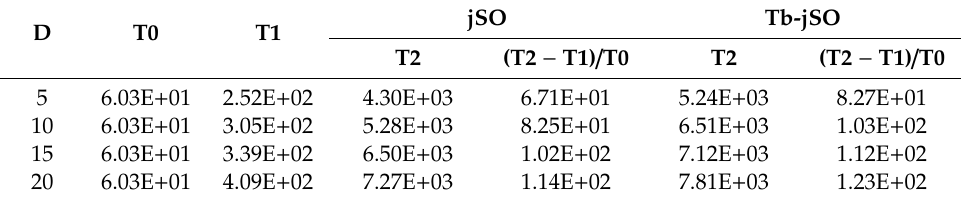
Table 3. Time complexity specified by CEC2020 technical document-jSO vs.